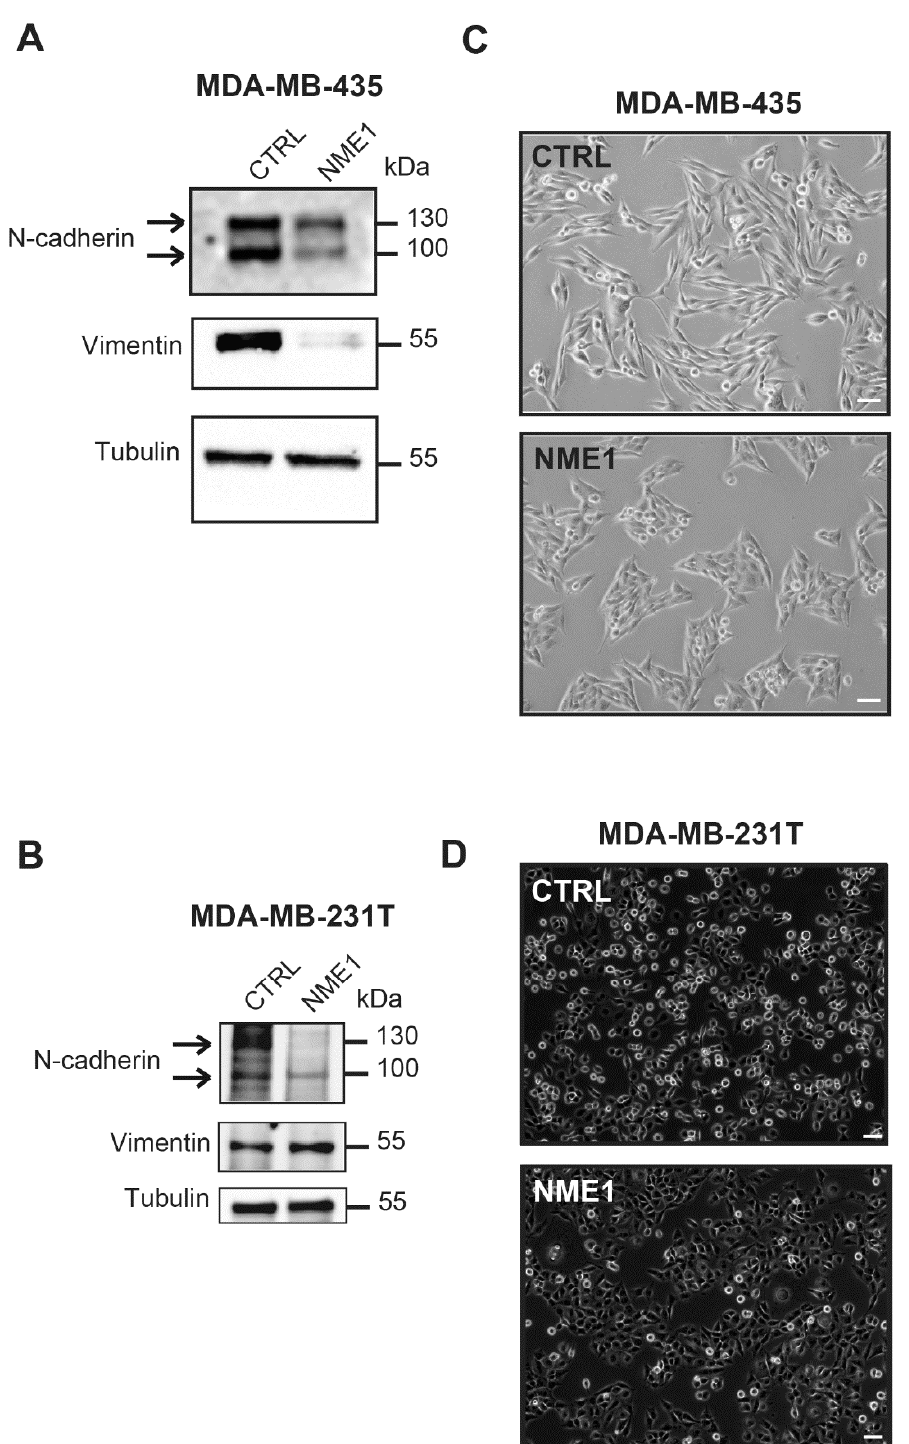
Figure 4. Stable overexpression of NME1 reverses EMT in mesenchymal breast cancer cells. ( A ) Lysates of MDA-MB-435 human breast carcinoma cells stably transfected with the empty control vector (CTRL) or with a vector expressing NME1 (NME1) were analyzed by Western blotting with antibodies against the indicated proteins. Equal loading was verified by Western blotting for tubulin. Molecular weights are indicated in kDa. ( B ) Lysates of MDA-MB-231T human breast carcinoma cells stably transfected with the empty control vector (CTRL) or NME1 -encoding vector (NME1) and analyzed as in ( A ). ( C ) Phase-contrast microscopy of MDA-MB-435 cells overexpressing NME1 . Scale bar, 50 µ m. ( D ) Phase-contrast microscopy of MDA-MB-231T cells overexpressing NME1 . Scale bar, 50 µ